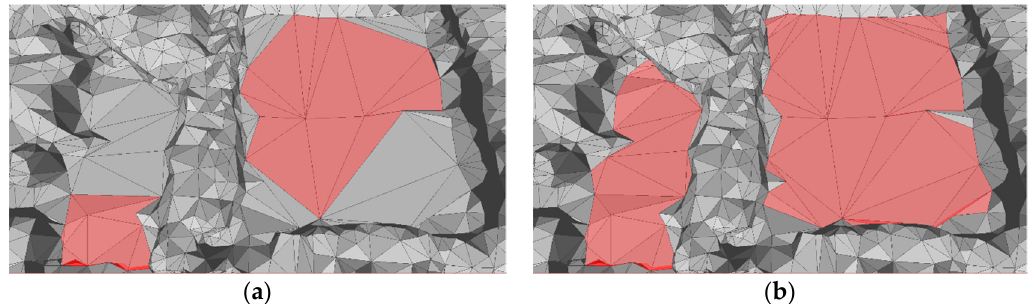
Figure 7. Planar face extraction compared with simplified ones at level 6 (simplification rate: 0.784) by DVDC ( λ = 2). Recognition of planar surfaces on the basis of ( a ) recognition of planar vertices with extension and ( b ) the dihedral angles of edges. It is evident that (b) better matches the continuity of the playground.